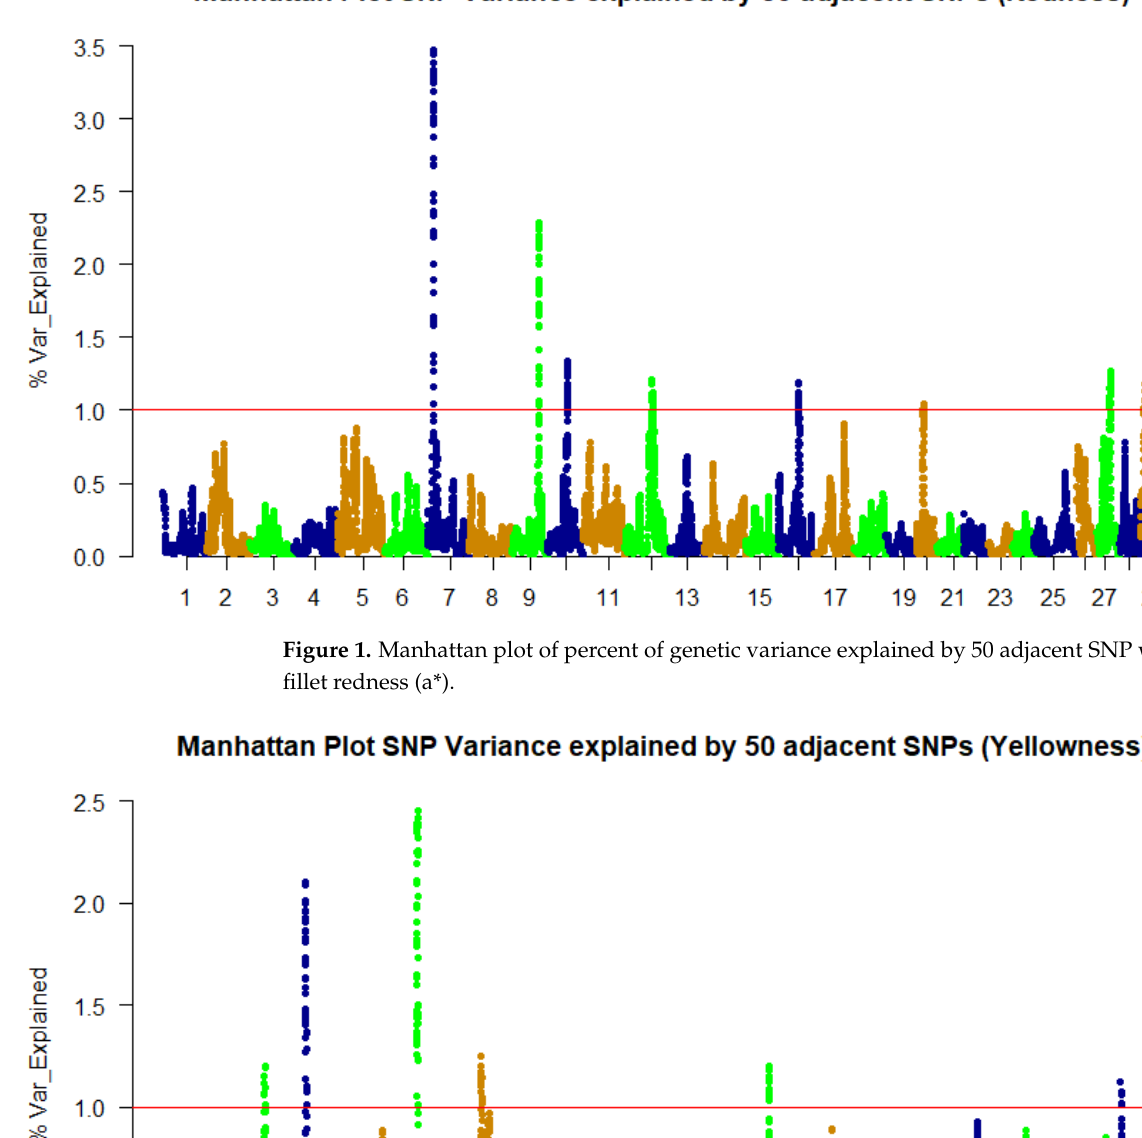
Figure 3. Manhattan plot of percent of genetic variance explained by 50 adjacent SNP windows for the fillet whiteness.